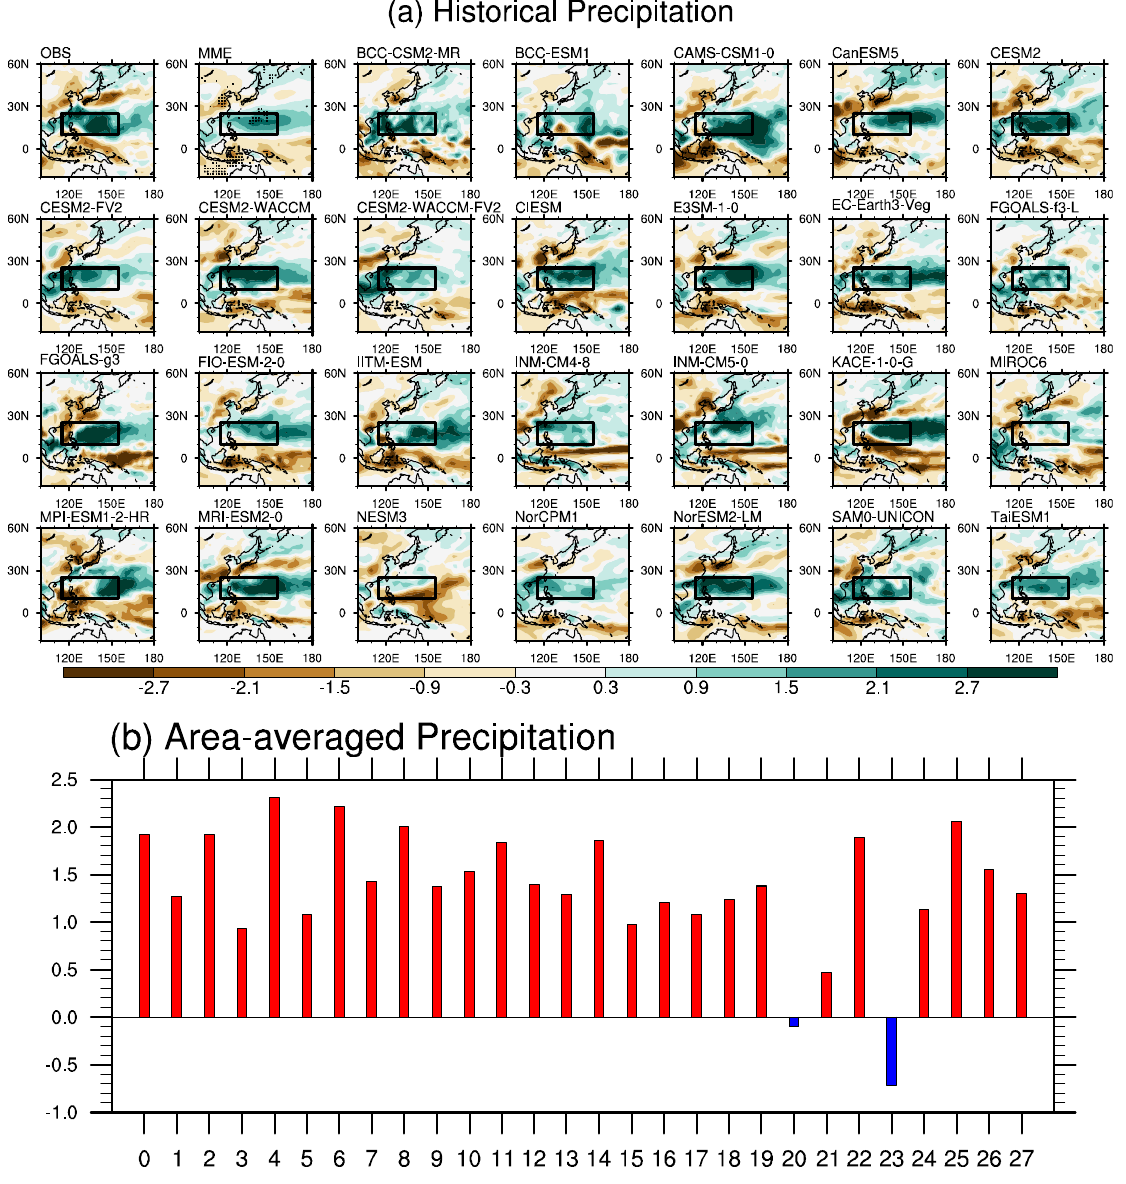
Figure 8. The same as in Figure 7, but for historical experiments.